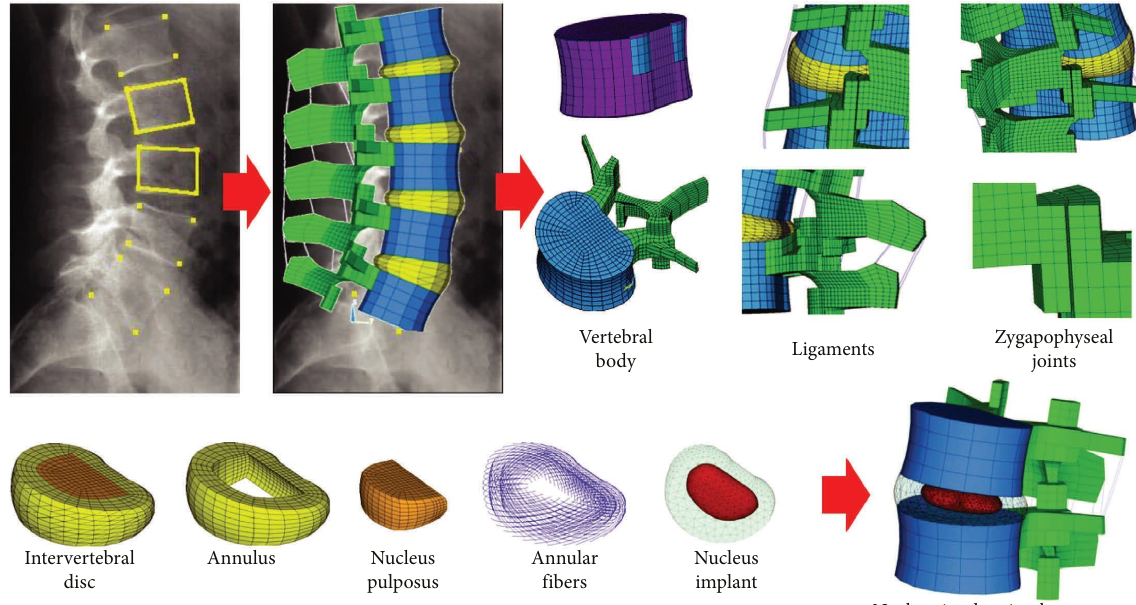
Figure 3: FEA model that we used in this